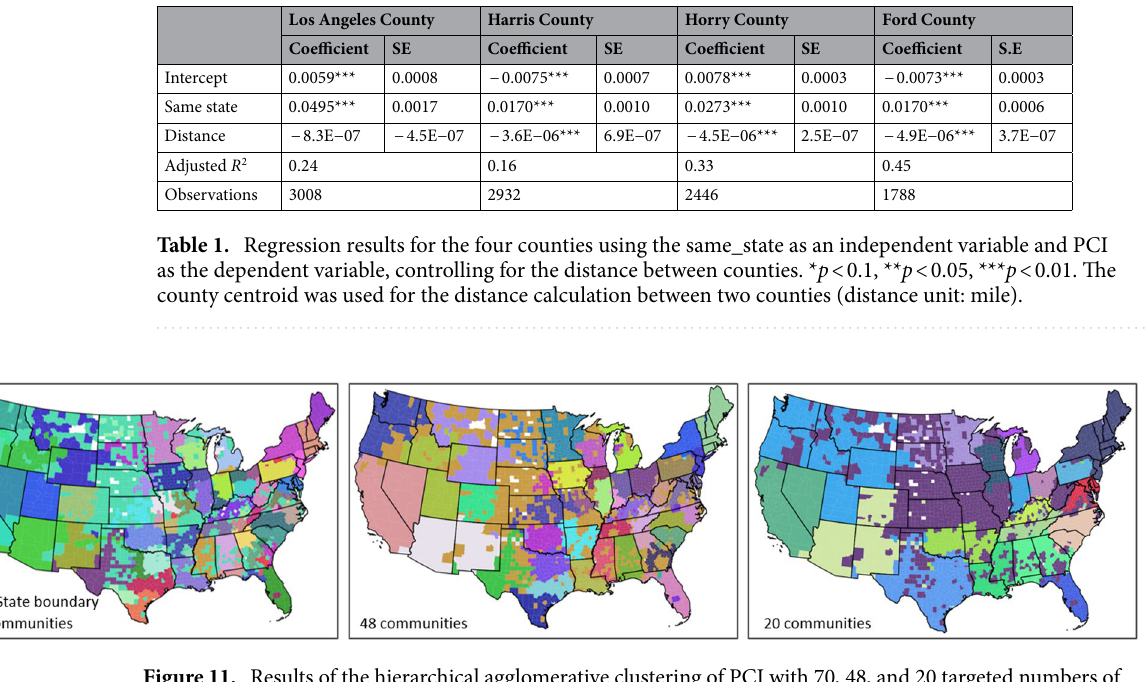
Figure 11. Results of the hierarchical agglomerative clustering of PCI with 70, 48, and 20 targeted numbers of communities for the contiguous US. Each unique color depicts a community. Counties of less than five Twitter users in our dataset are ignored (white areas). The maps were generated using GeoPandas version 0.90.0 with Python (https:// geopa ndas.